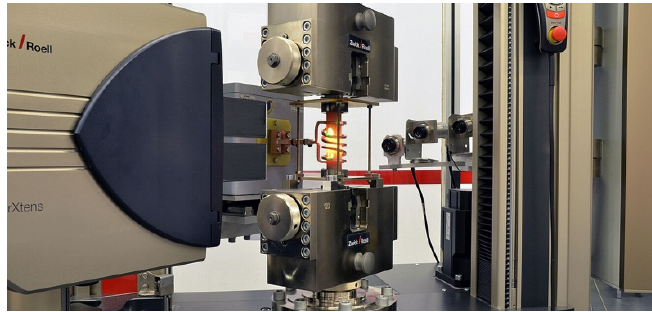
Figure 6. Zwick Roell thermal strain testing rig.